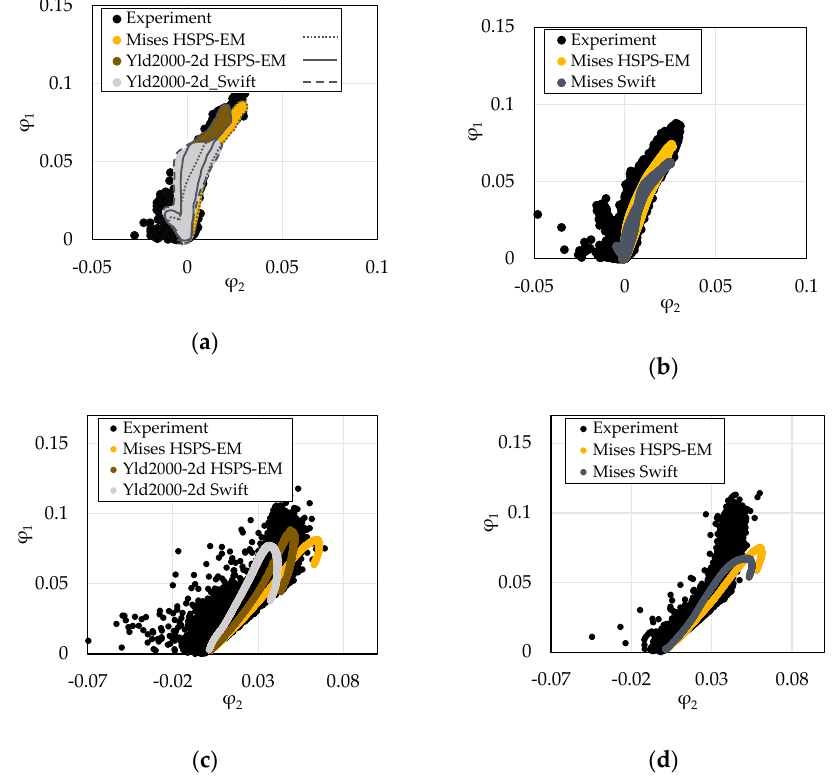
Figure 8. Forming limit diagram for Nakajima100 specimen ( a ) TH700 ( b ) TH620 and limited dome height experiment ( c ) TH700 and ( d ) TH620.